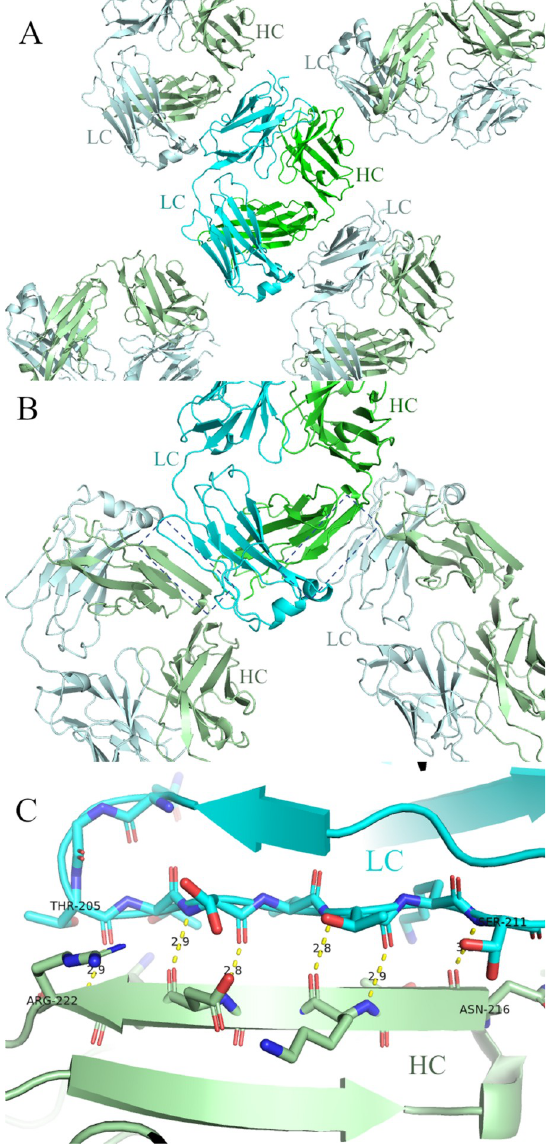
Fig 4. Crystal packing in CK constructs. (A) Crystal packing in un-engineered dupilumab parental Fab (PDB accession 6WGB). No G strand beta packing is present. (B) One plane of crystal packing in crystal kappa version (PDB: 6WG8). Each kappa constant (blue and light blue) forms a beta sheet with a nearby constant heavy 1 domain (green and pale green). (C) beta sheet formed between the G strand of the constant kappa domain (cyan) and the G strand of the constant heavy 1 domain (pale green). Sheet extends from kappa T205 to S211 and heavy N216 to R222 which is pseudo-symmetric and centered between the kappa V208 and CH1 V219.